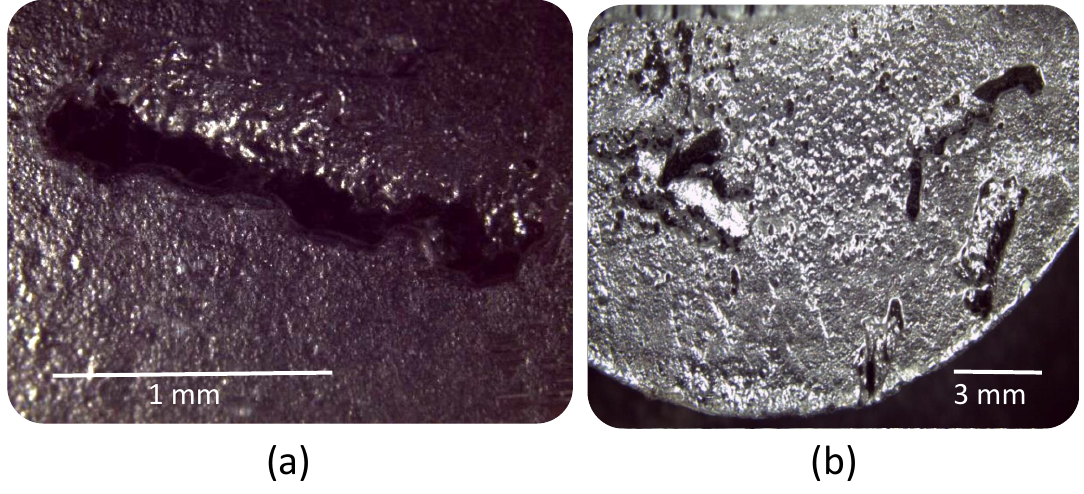
Figure 14. ( a ) Inclusion of sand and ( b ) flow marks.